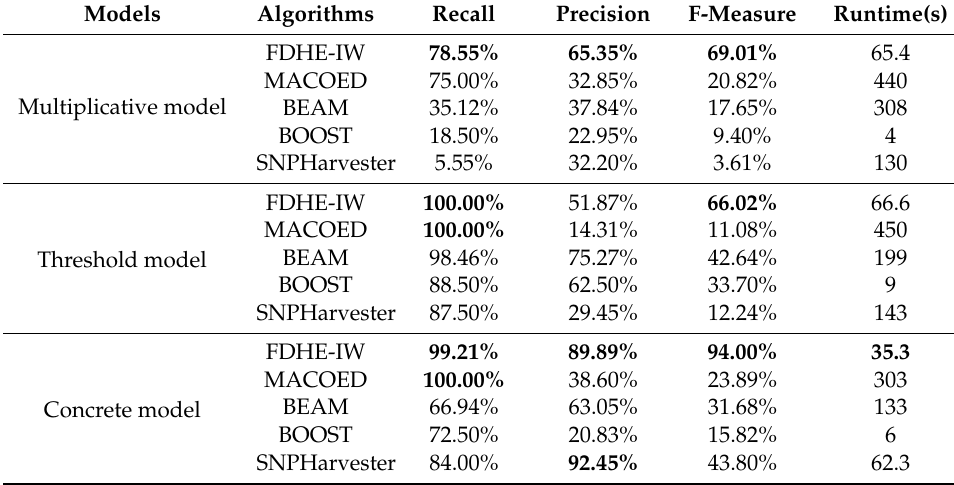
Table 3. Performance comparisons on recall , precision and F-measure (1000 SNPs, 4000 sample size).